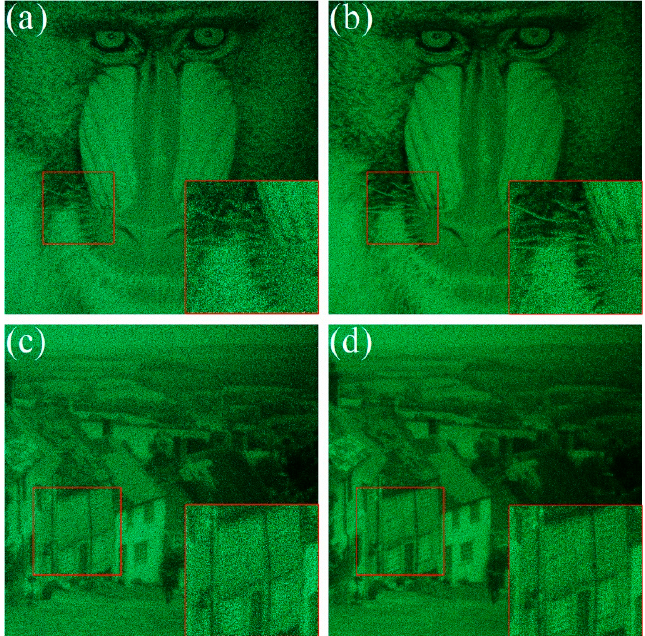
Figure 9. Optical reconstructions: reconstructed “baboon” images with ( a ) GS algorithm and ( b ) WCIA; reconstructed “Goldhill” images with ( c ) GS algorithm and ( d ) WCIA.